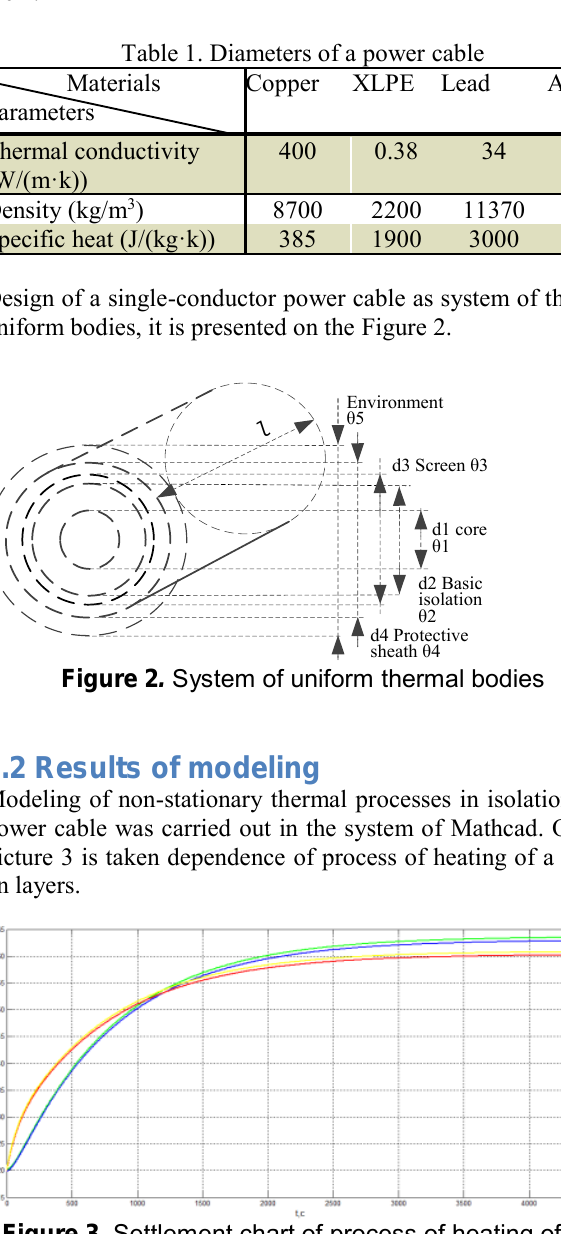
Figure 3. Settlement chart of process of heating of the